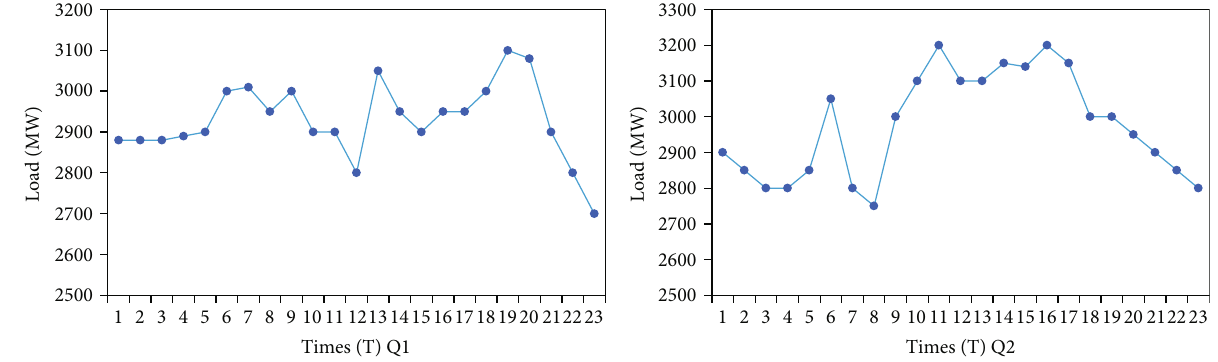
Figure 6: Typical daily load curve in di ff erent quarters.